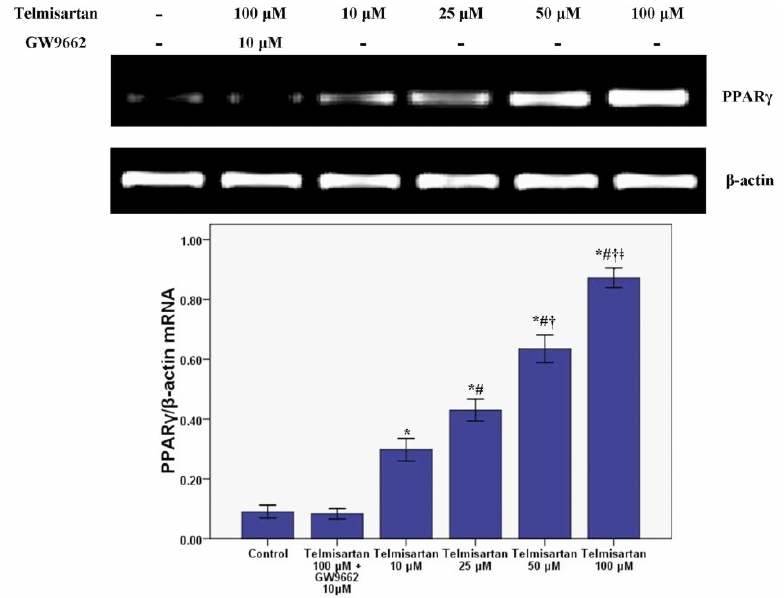
Figure 5. Telmisartan enhances the mRNA expression of PPAR γ in A549 cells. The mRNA expression of PPAR γ in A549 cells treated with 4 concentrations of telmisartan (10, 25, 50 and 100 μ M) or GW9662 (10 μ M) for 48 h were measured. Quantitative data were presented as mean ± SD ( n = 4). * p < 0.05 compared with Control. # p < 0.05 compared with 10 μ M telmisartan. † p < 0.05 compared with 25 μ M telmisartan. ǂ p < 0.05 compared with 50 μ M telmisartan.